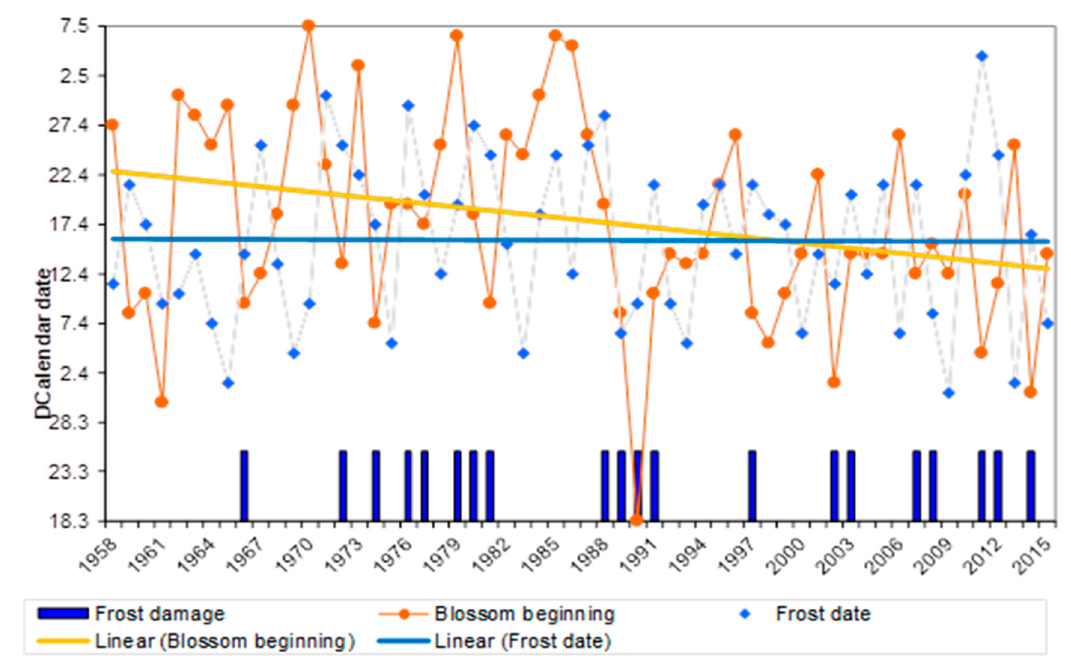
Figure 5. Advancement in flowering at beginning phase for pear cv. ‘A Lucas’ during the last 60 years in comparison with the calendar dates of late spring frost at Klein-Altendorf Campus.